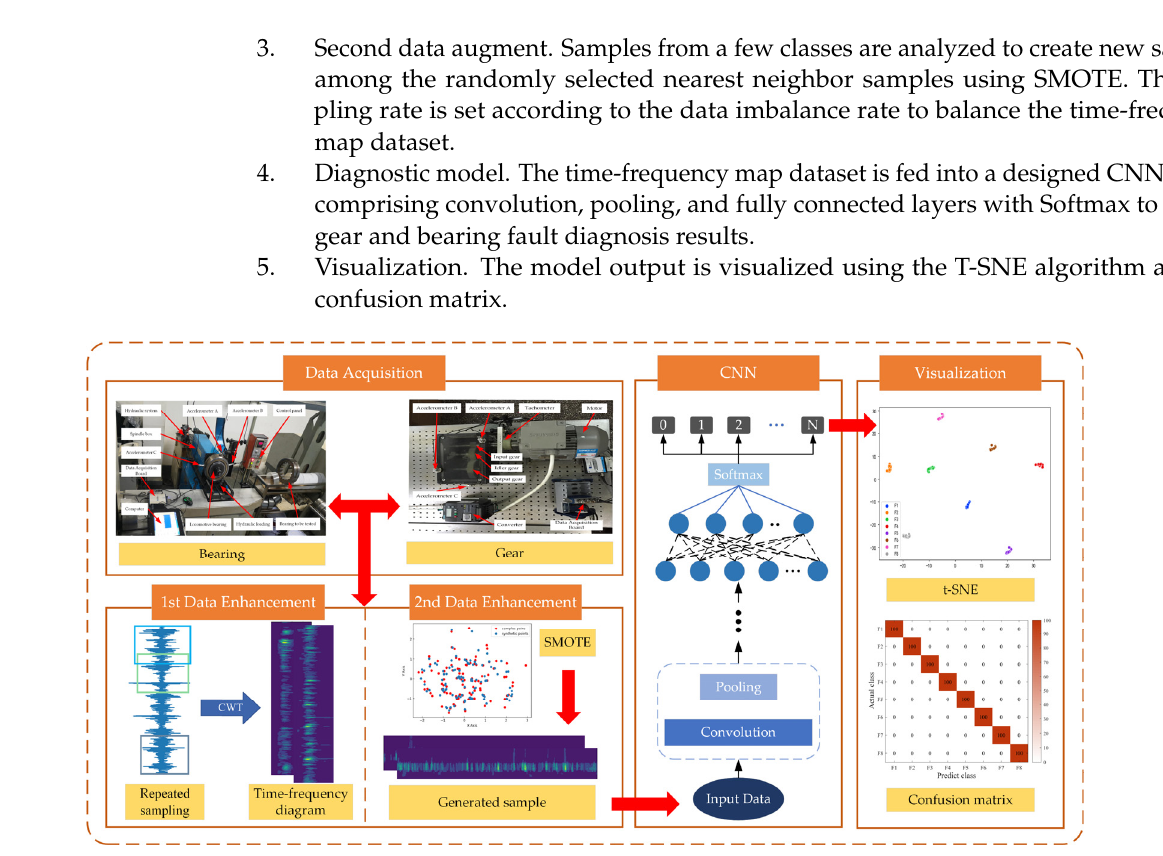
Figure 5. Imbalanced fault diagnosis flow chart of rotating machinery based on TFFO and CNN. First, the bearing and gearbox raw vibration signals are collected. Second, sliding segmentation is used for repeated sampling, and CWT is applied to generate time − frequency images. Third, the SMOTE is utilized to generate minority samples again. Finally, an improved CNN based on LeNet − 5 is established to achieve intelligent fault diagnosis while the features are visualized by t − SNE, and results are displayed by a confusion matrix.